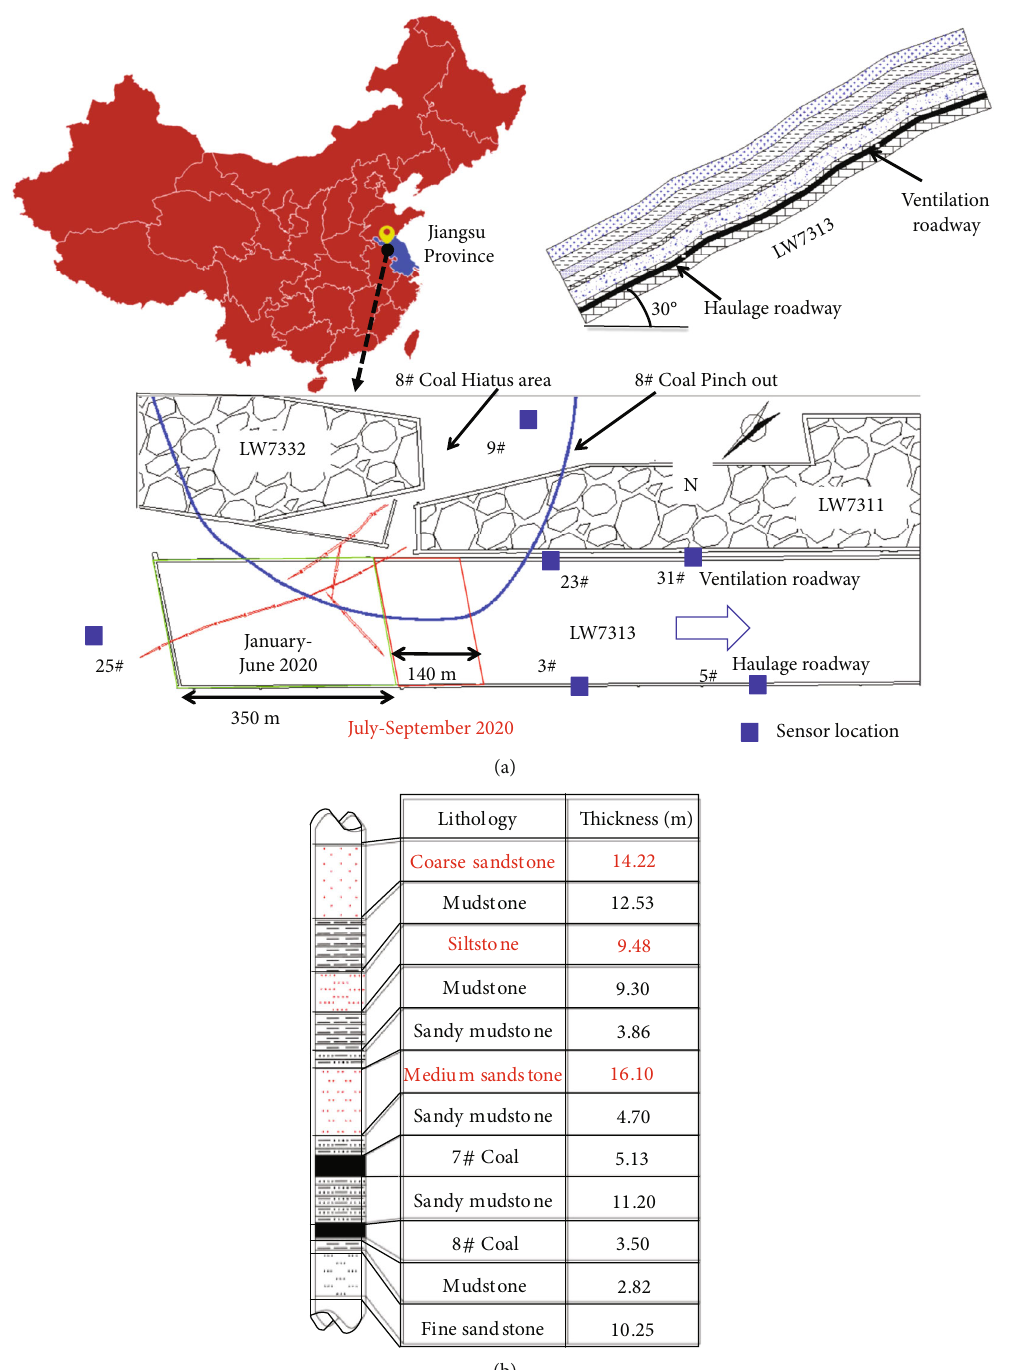
Figure 1: Mining conditions: (a) layout of LW7313; (b) comprehensive bar chart of the working